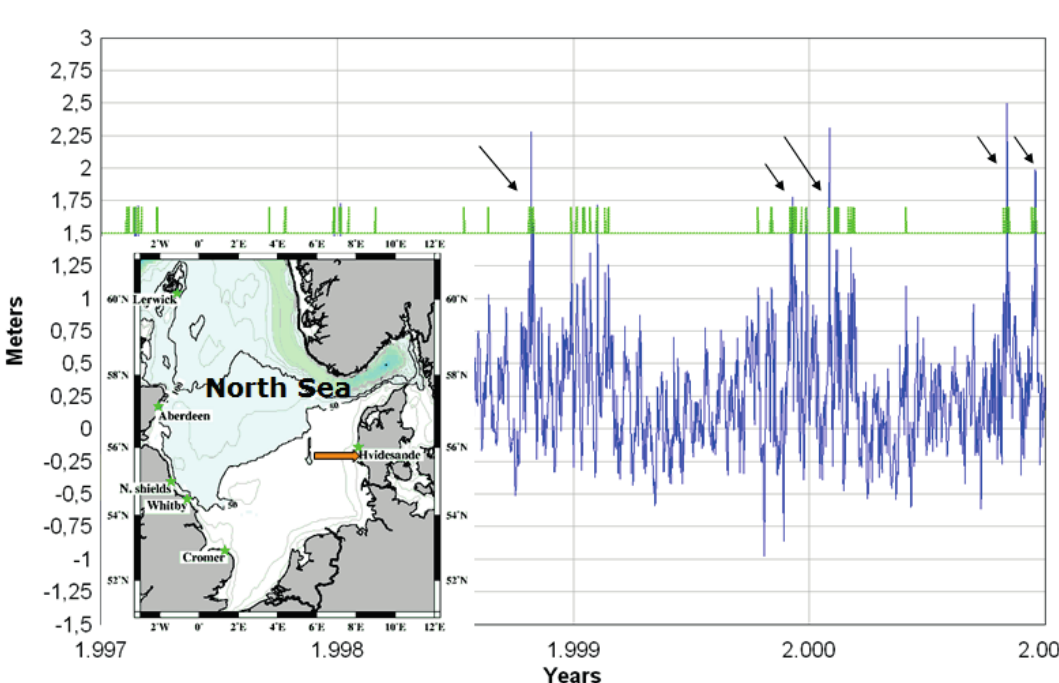
Fig. 1 The location of the Hvidesande tide gauge recorder on the west coast of Denmark and the sea level variations (including tides) recorded by the gauge for the 1997–2001 period (blue). Episodes when sea level was higher than 2 times the standard deviation are marked with green, and 5 episodes of sea level higher than 3 times the standard deviation are marked with arrows. All heights are given in metres.